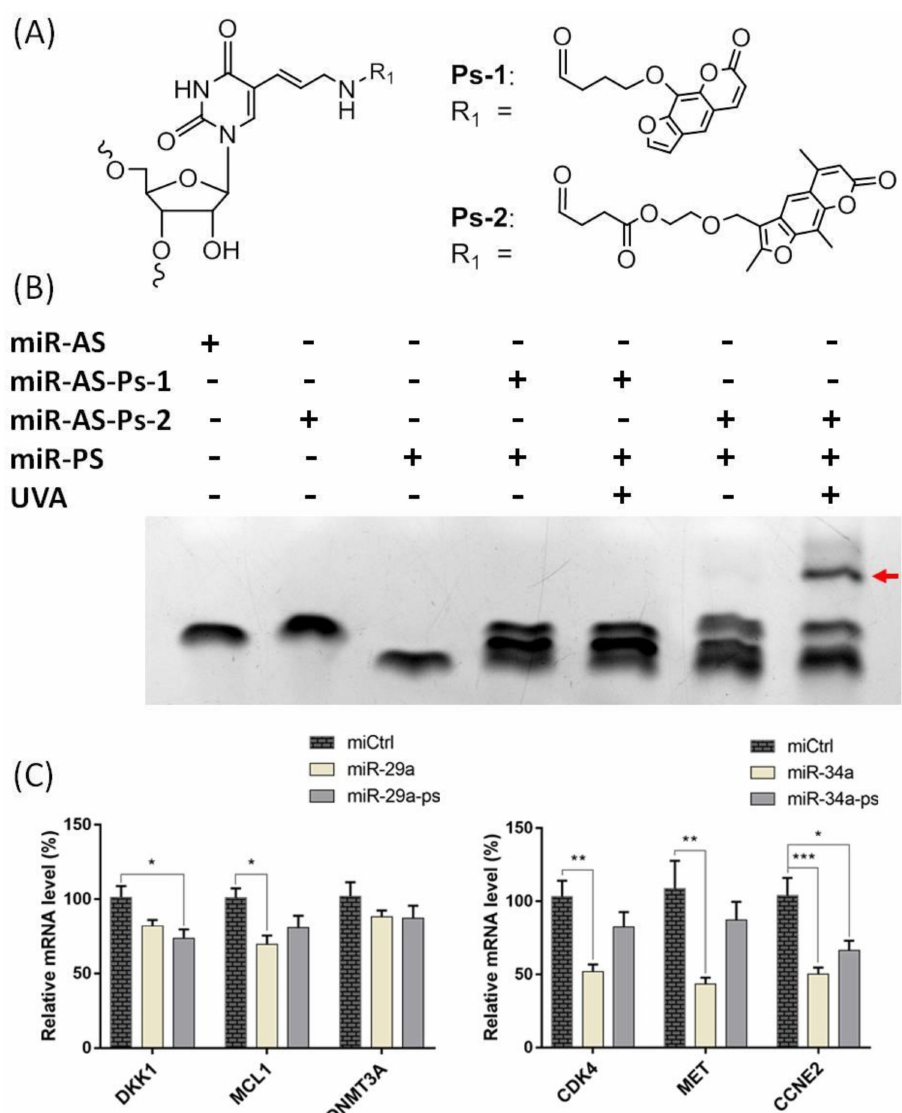
Figure 2. Structures, photo reactivity and bioactivity of psoralen-functionalized miR probes. ( A ) 5-N-U located in the seed sequence of miR reacts with NHS-activated psoralen (Ps-1 and Ps-2) to give photoactive probe (miR-AS-Ps-1 and miR-AS-Ps-2); ( B ) UV reactivity of psoralen modified miR-29a probes was tested for the efficiency of crosslinking between miR-AS-Ps and its complementary strand miR-PS; AS, antisense strand; PS, passenger strand. Red arrow indicates the product of UV mediated reaction; and, ( C ) RNA interference activities of the psoralen-functionalized probes were assessed by RT-qPCR for the representative known targets for miR-29a (left) and miR-34a (right). ACTB was served as the internal control. All error bars represent mean ± SD of three independent experiments, and samples with p < 0.05 (one-way ANOVA) are marked with asterisks (*, p < 0.05; **, p < 0.01; ***, p <